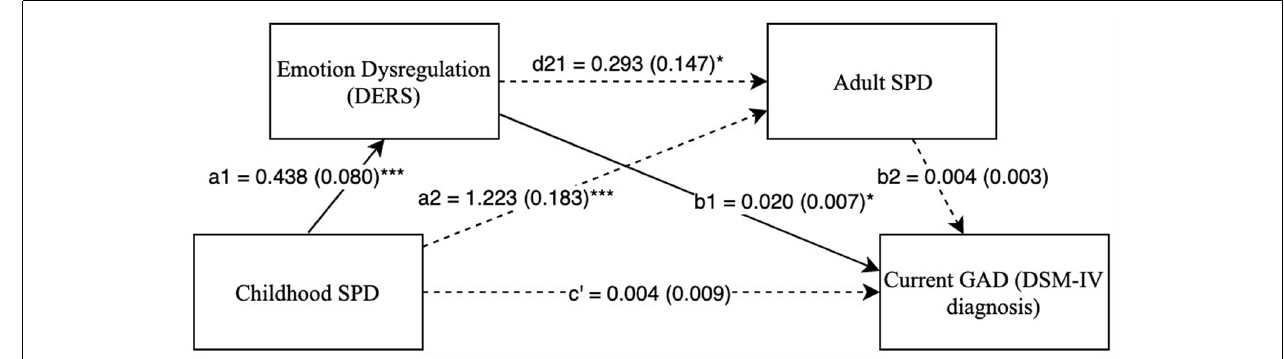
FIGURE 3 | Childhood SPD predicting current GAD with emotional dysregulation as mediator 1 and adult SPD as mediator 2. Note: ∗ p < 0.05, ∗∗∗ p < 0.001. Standard errors are in parentheses, solid lines represent significant indirect paths, a1 = unstandardized regression coefficient for the IV predicting the mediator 1, a2 = unstandardized coefficient for the IV predicting mediator 2 with mediator 1 in the model, d21 = unstandardized regression coefficient for mediator 1 predicting mediator 2 with IV in the model, b1 = unstandardized regression coefficient for mediator 1 predicting the DV with IV and mediator 1 in the model, b2 = unstandardized regression coefficient for mediator 2 predicting the DV with mediator 1 and the IV in the model, c (cid:48) = unstandardized coefficient for the IV predicting the DV with both the mediators in the model (indirect effect). SPD, Sensory Processing Disorder symptoms; DERS, Total score on Difficulty in Emotion Regulation Scale; SPDI, Sensory Processing Disorder Interview, version 2. Sex and race are included as covariates in all regression equations, coefficients of covariates are omitted for clarity.